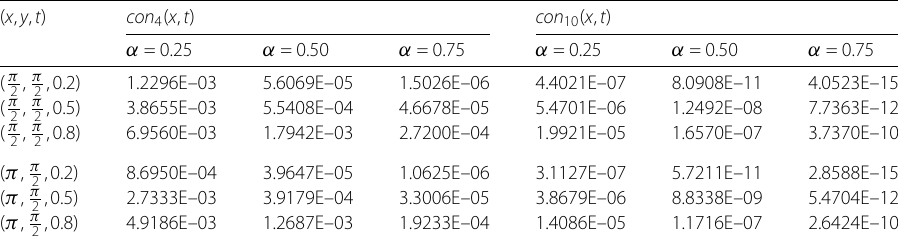
Table 2 The consecutive errors of K α (2,2) for different values 0 < α < 1 at some